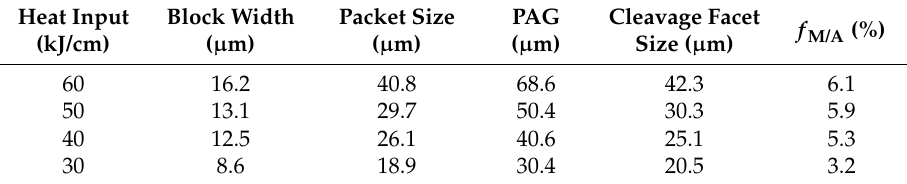
Figure 3. The optical micrographs of the simulated thermal cycle treated specimens with different heat inputs: ( a ) 30 kJ/cm; ( b ) 40 kJ/cm; ( c ) 50 kJ/cm; ( d ) 60 kJ/cm. Table 2. Results of the microstructure quantification.